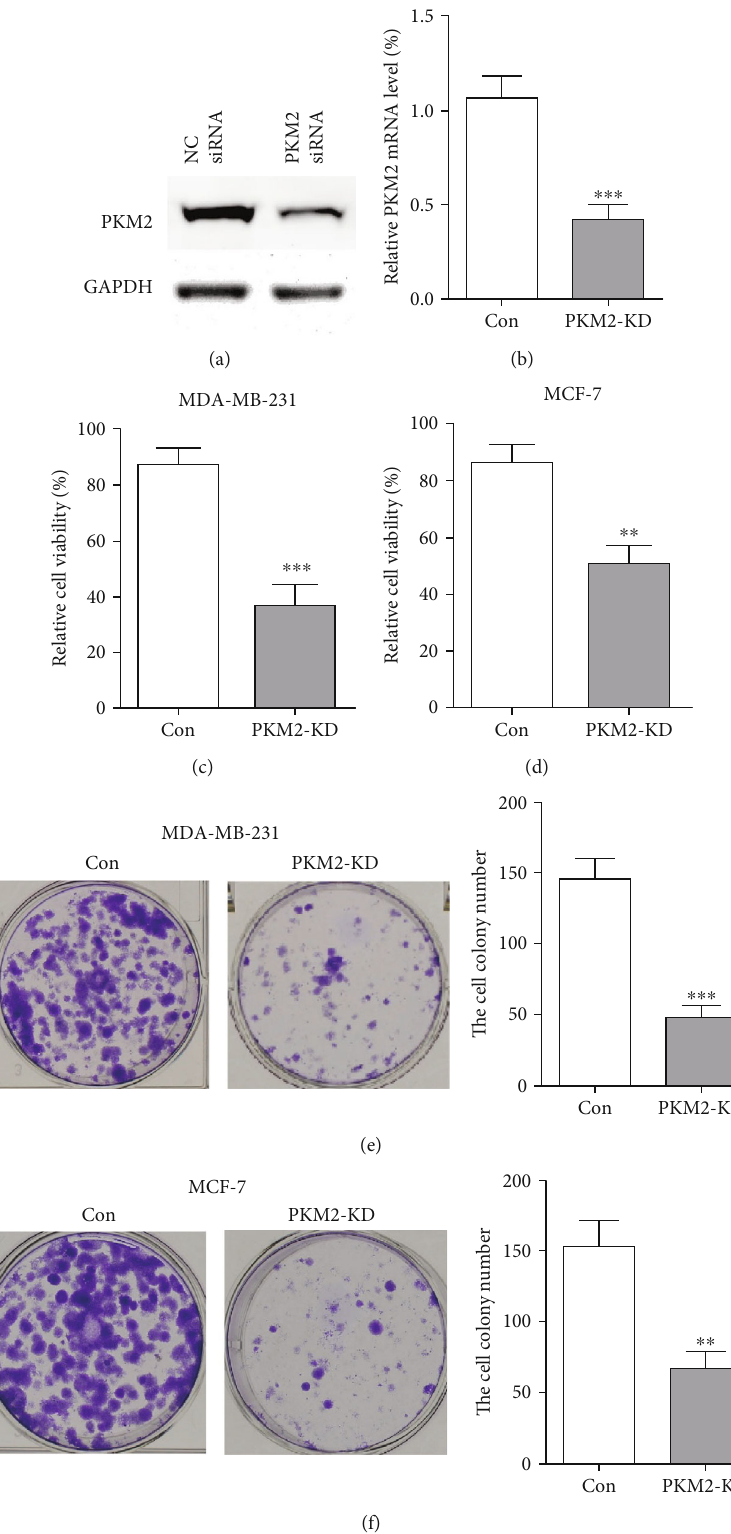
Figure 3: PKM2 is required for breast cancer cell viability. (a) PKM2 protein level was reduced by PKM2 siRNA, and GAPDH was used as a loading control. (b) Q-RT PCR analysis of PKM2 mRNA levels normalized to GAPDH in the control group and PKM2-KD cells. (c), (d) Cell viability was measured by CCK-8 assay in MDA-MB-231 and MCF-7 cells following PKM2 silencing by siRNA. (e), (f) Colony formation